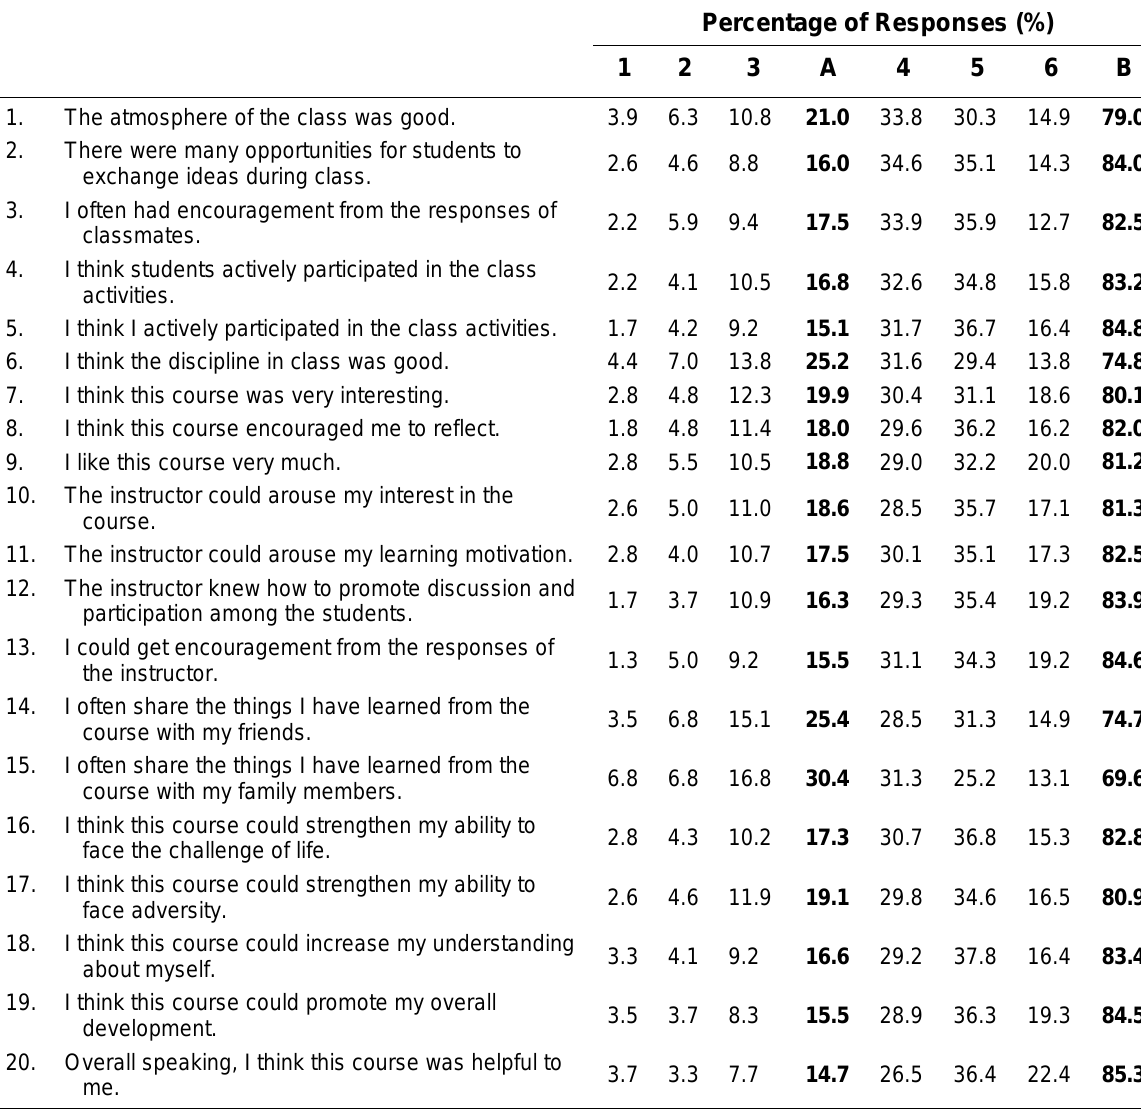
Findings Based on the Subjective Outcome Evaluation Strategy Percentage of Responses